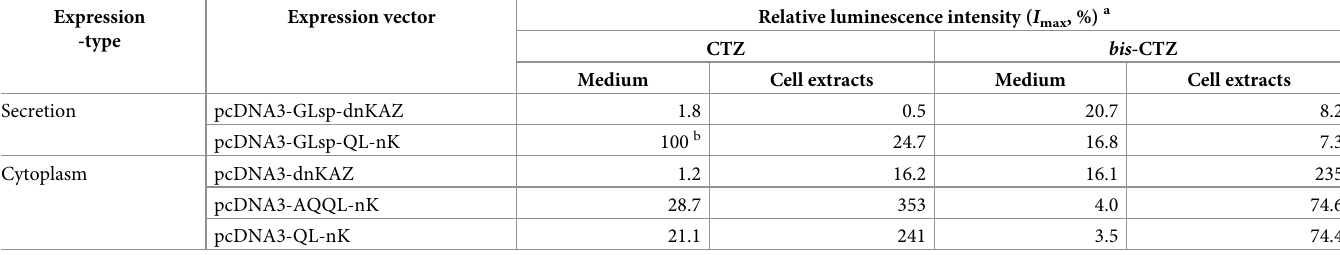
Table 5. Expression of QL-nanoKAZ in the presence or absence of the secretory signal peptide sequence from Gaussia luciferase (GLsp) in CHO-K1 cells. Expression